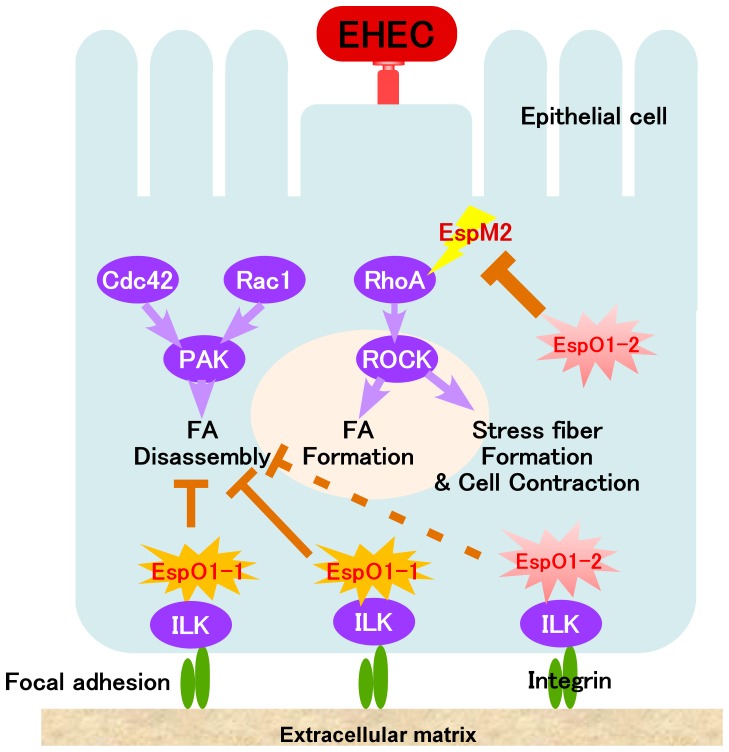
A proposed model for the role of EspO1-2 in an EHEC-infected cell.EspO1-2 interacts with EspM2 in EHEC-infected cells to suppress EspM2-enhanced host RhoA activity.